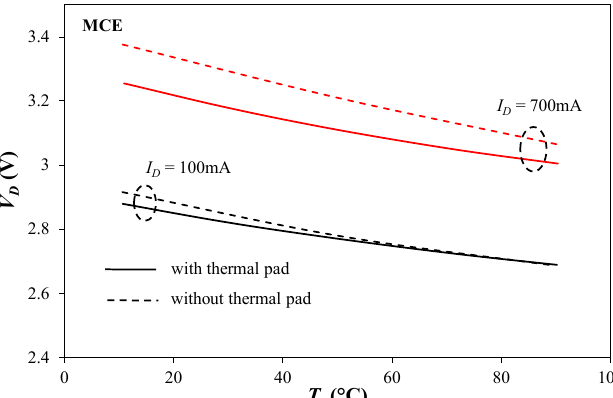
Figure 6. Measured dependences of the forward voltage of MCE diodes on the cold plate temperature for different forward current values.